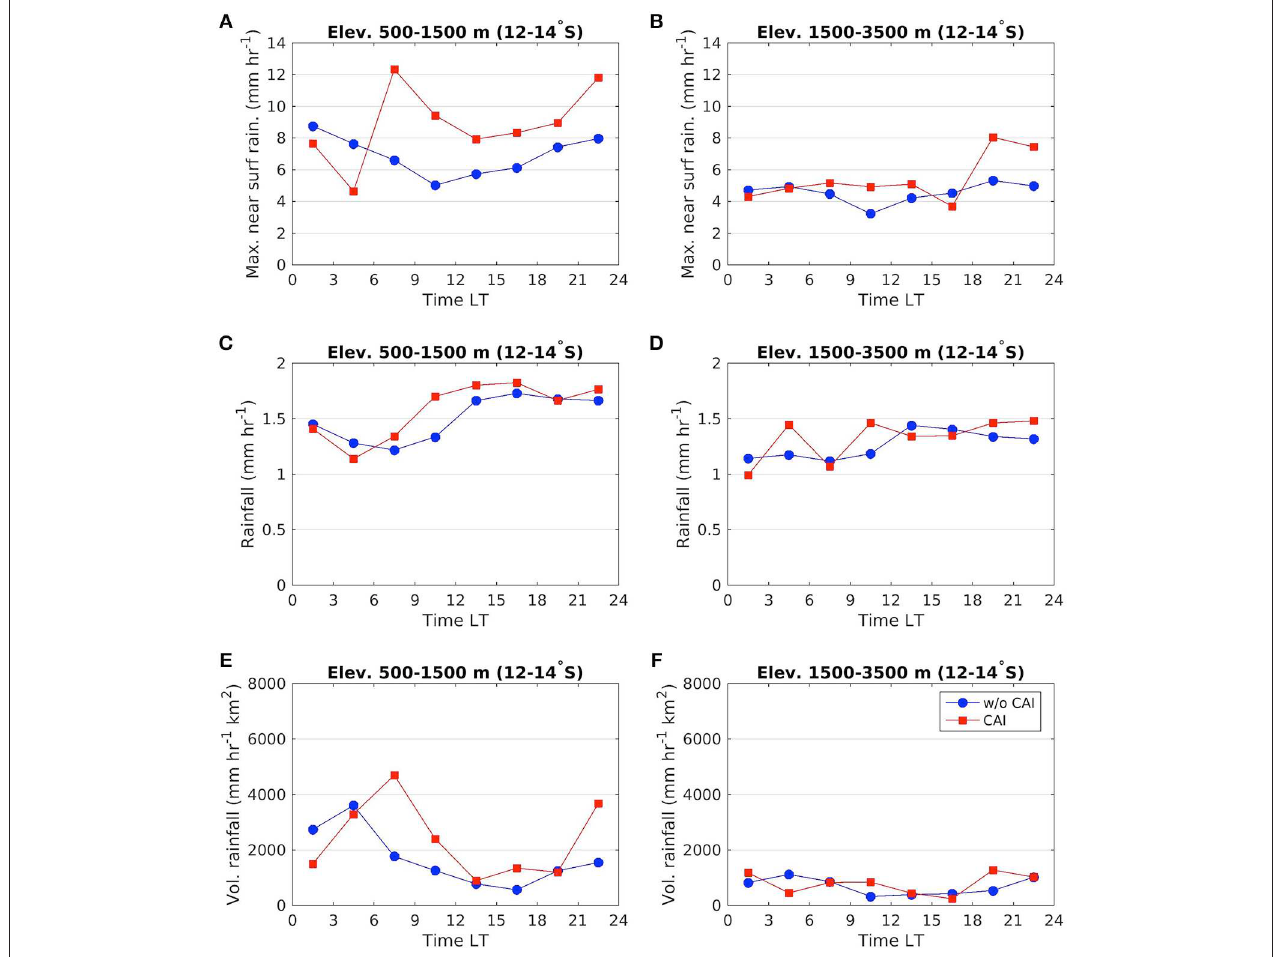
FIGURE 13 | Diurnal cycle of (A,B) maximum near surface rain, (C,D) spatially averaged rain, and (E,F) volumetric rain associated with TRMM PFs over the Andes during ONDJFM between 12 ◦ and 14 ◦ S latitude (see Figure 12 ) for two elevation bands 500–1,500m and 1,500–3,500m. Circles show non-CAI climatology. Squares show the mean values between 1 day before (day-1) and 1 day after (day + 1) the detected CAI events according to the methodology described in section Data and